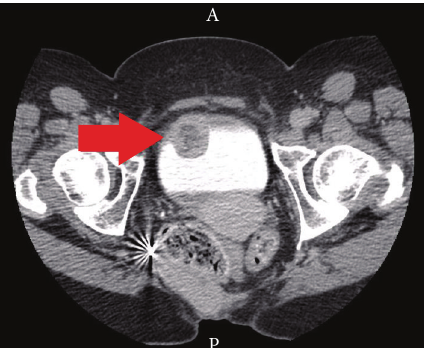
Figure 1: CT with contrast of the abdomen and pelvis demonstrating 3.2 cm anterior bladder mass (red arrow). The mass is a smooth, well- circumscribed lesion, which would be atypical for urothelial cell carcinoma.